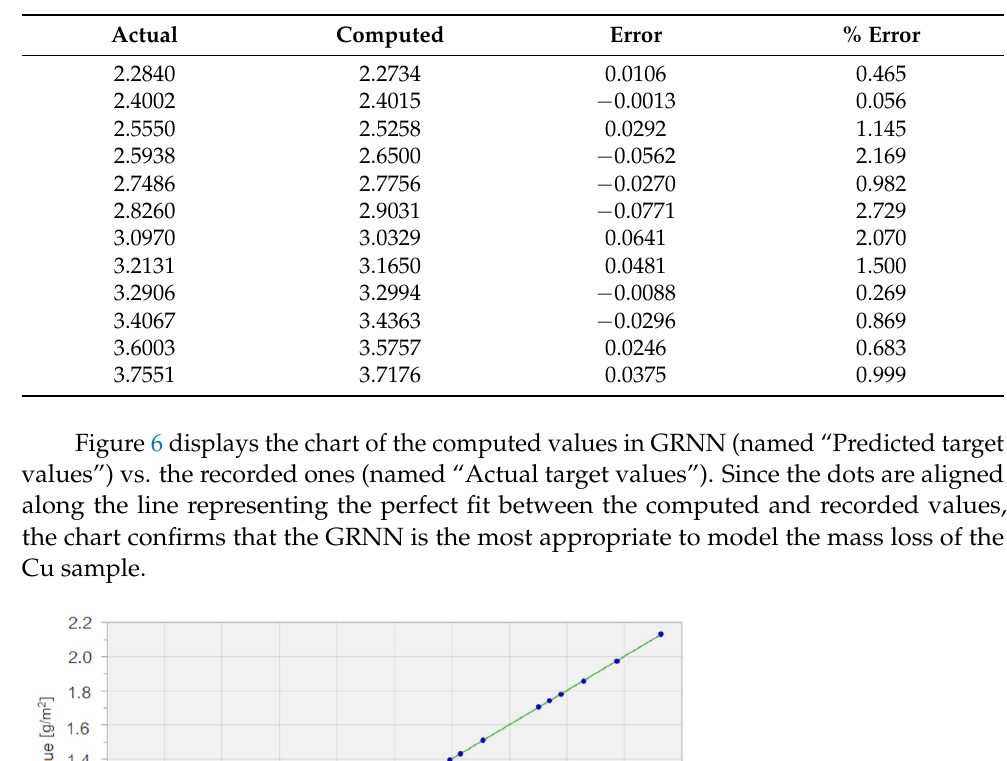
Table 2. Actual and computed values in GRNN on the Test set on the Cu sample.